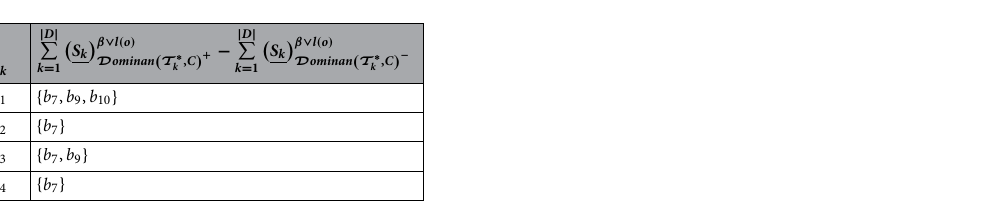
Table 7. Decision table with β = 0.90, l = 1 .